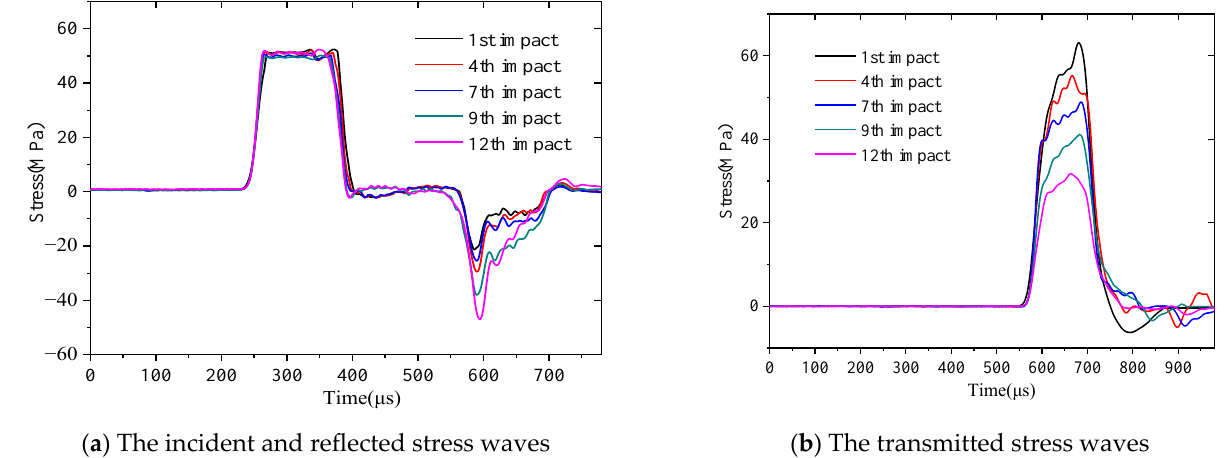
Figure 8. Waveforms of repeated SHPB impact tests.